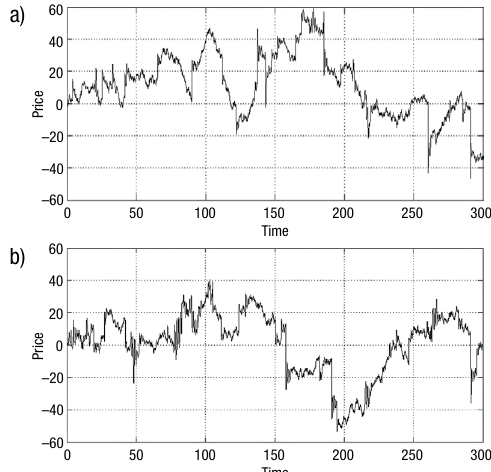
Fig. 22. Price development – simulated path 1 (a), price development – simulated path 2